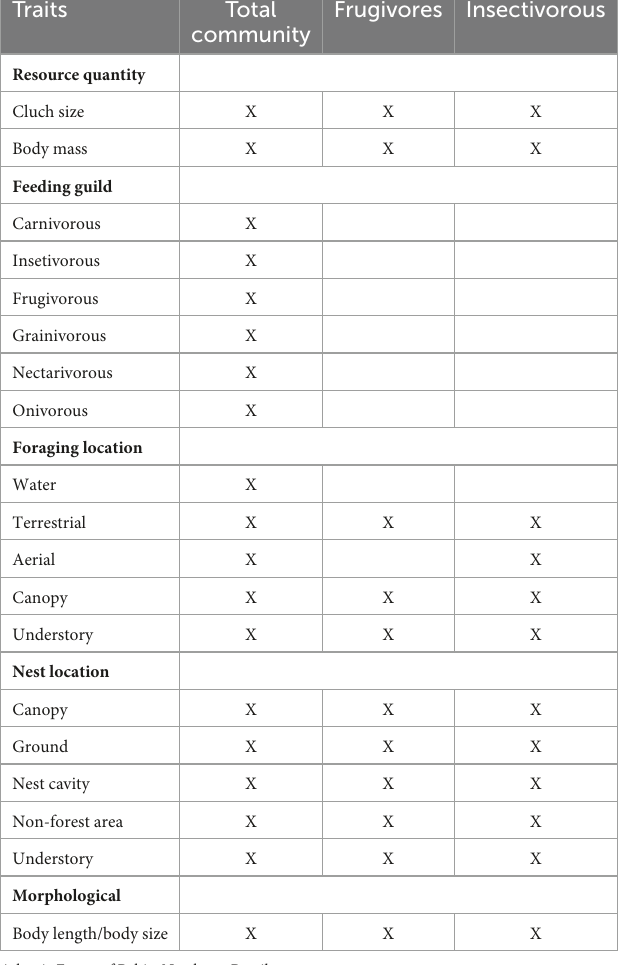
TABLE 1 Traits used to assess species response to habitat loss over the entire community, frugivorous and insectivorous birds. Traits Total Frugivores community